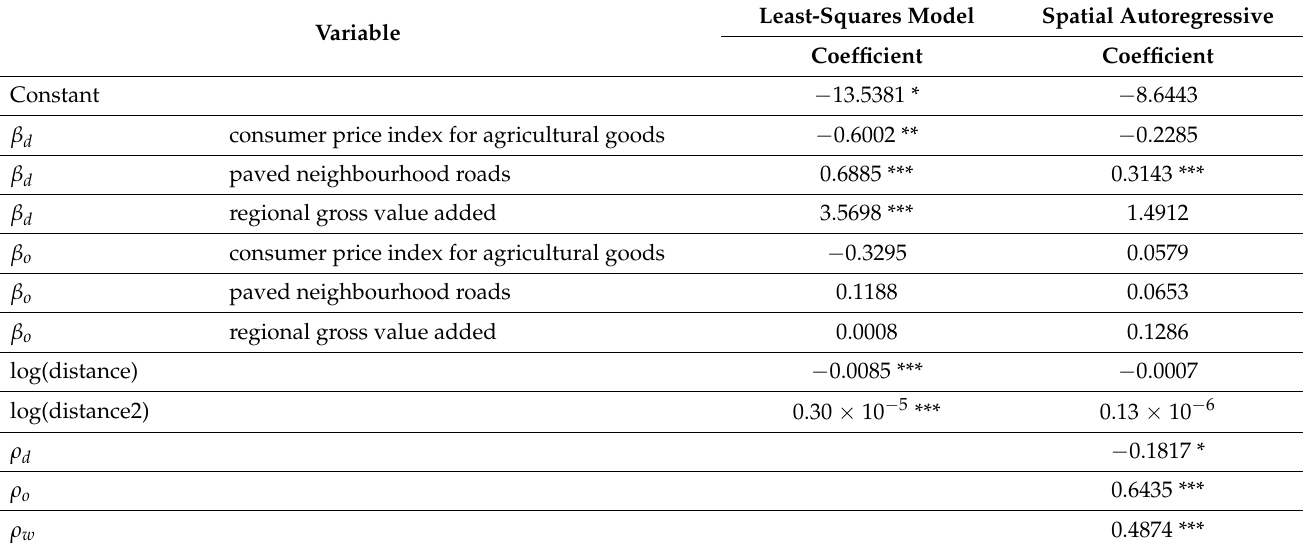
Table 4. Coefficient estimates for least-squares and spatial autoregressive